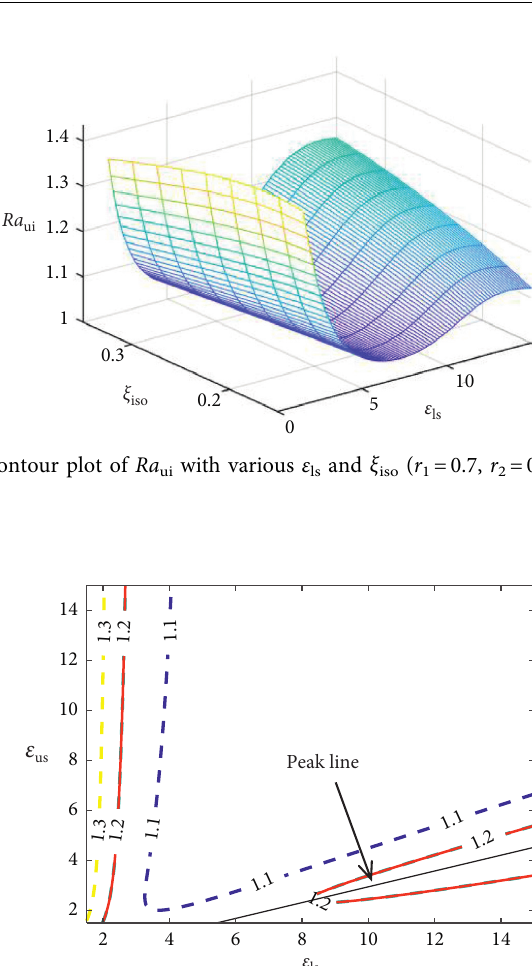
Figure 9: Contour plot of Ra